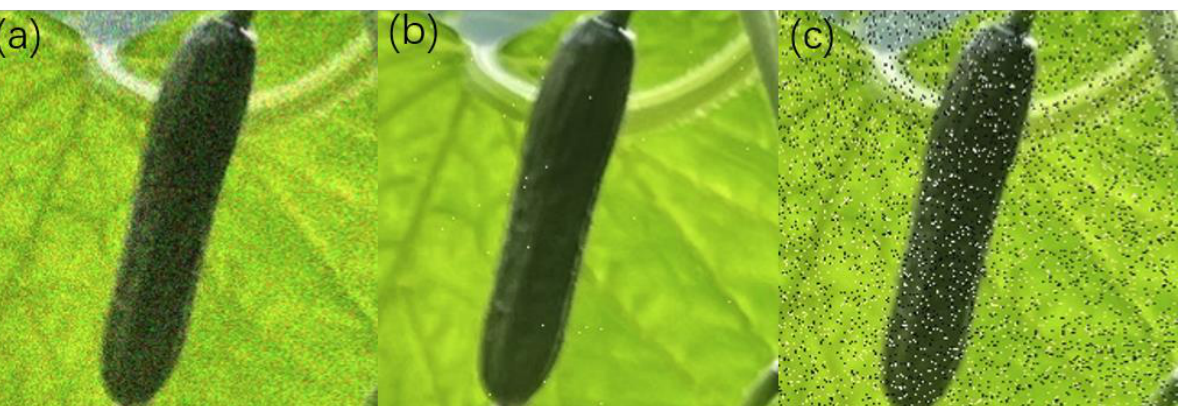
4 of 16 Figure 2. Positive labels ( a – c ) with different degrees of occlusion and negative labels ( d , e ). For each category: ( a ) intact cucumber; ( b ) partial cucumber occluded by leaves; ( c ) cucumber sliced by stems or petioles; ( d ) female flower; and ( e ) leaves and stems.